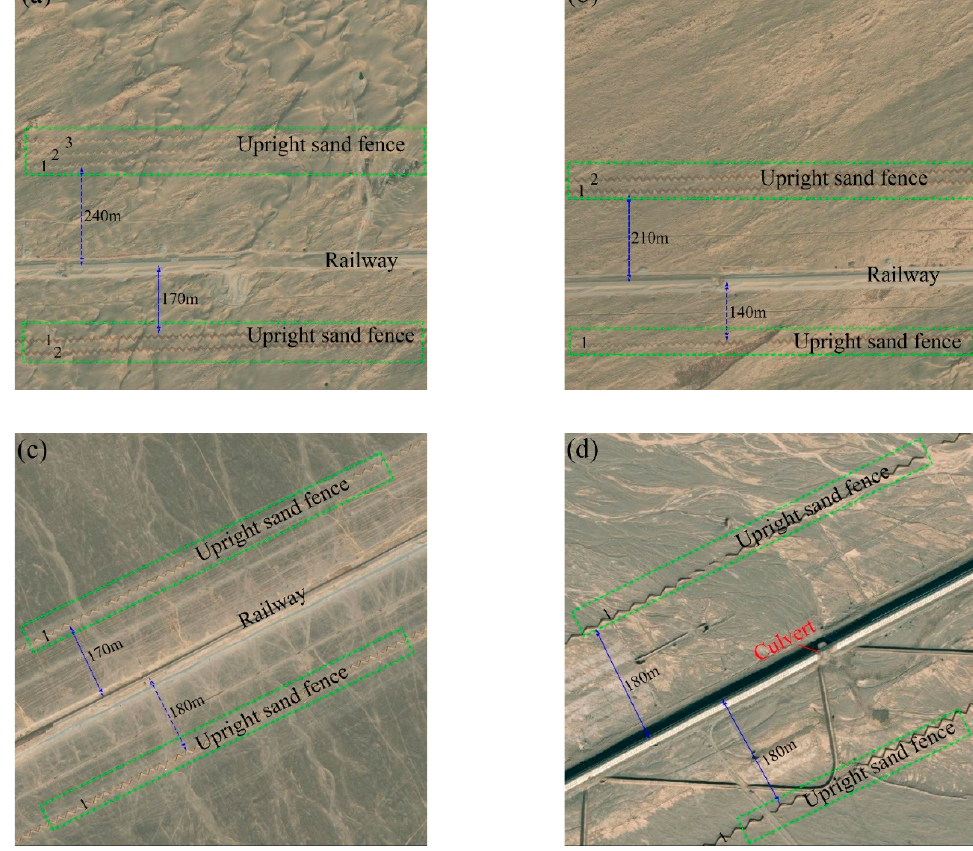
Figure 12. Distribution of sand control system along railway: ( a – d ) distances between upright sand fences on both sides and railway and number of upright sand fences. 1–3 represents the upright sand fences.